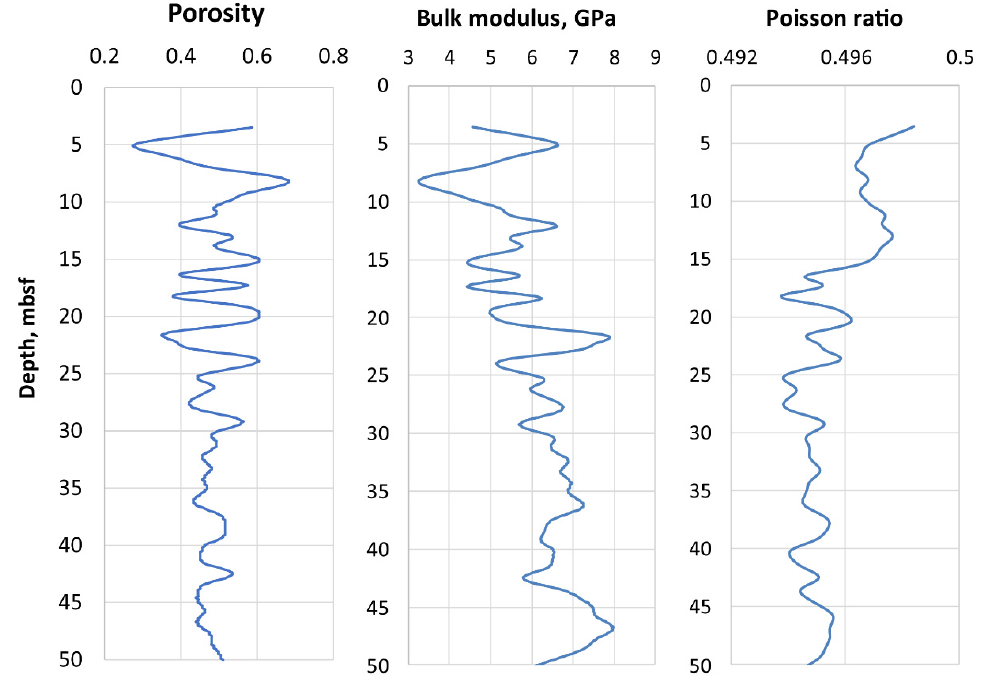
Figure 3. Porosity, bulk modulus, and Poisson’s ratio along the project well calculated from the seismic data (P- and S-wave velocities and density) and density of solid grain material and sea water. The elastic moduli and porosity of the sediments were further used for the rock-physics modeling and preconsolidation